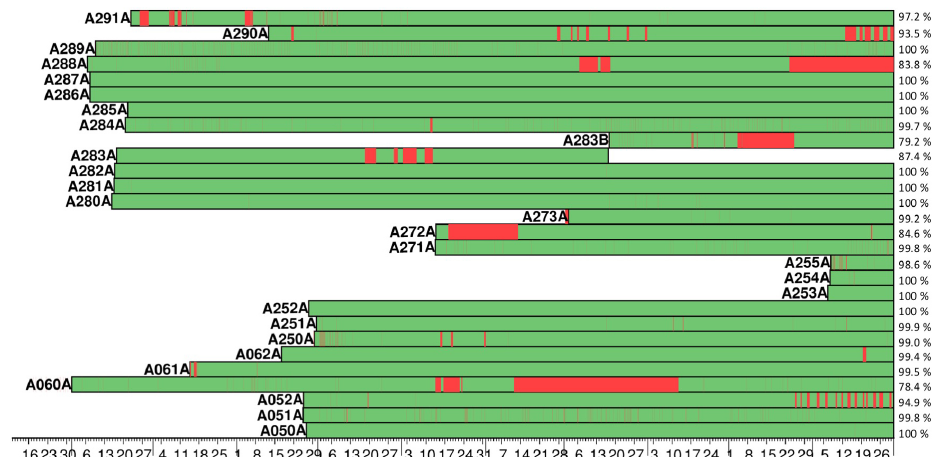
Figure 7. Data availability (green), as a function of time, of the 27 Swiss-AlpArray stations from real-time communications from the installation day to the end of June 2016. The gaps (red) are constantly filled once the data are manually collected and stored in the database. Large gaps for the stations A060A, A272A, A283A, A283B and A288A are not restorable because of station operation interruptions (mainly power interruption for more than one week or serious problems with data logger and sensor). Intermittent gaps are mainly due to connection problem (low bandwidth) and will be filled once the data are manually